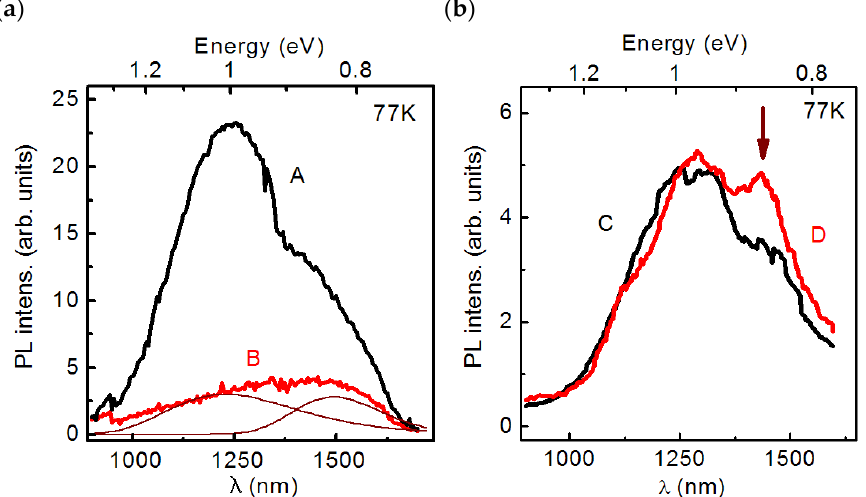
Figure 5. Steady-state PL spectra of HSs ( a ) A and B , and ( b ) C , and D , measured under the nonresonant excitation in an AlP matrix at the temperature of 77 K and P ex = 25 W/cm 2 . Thin brown lines in figure ( a ) show the PL spectrum deconvolution to Gaussians.